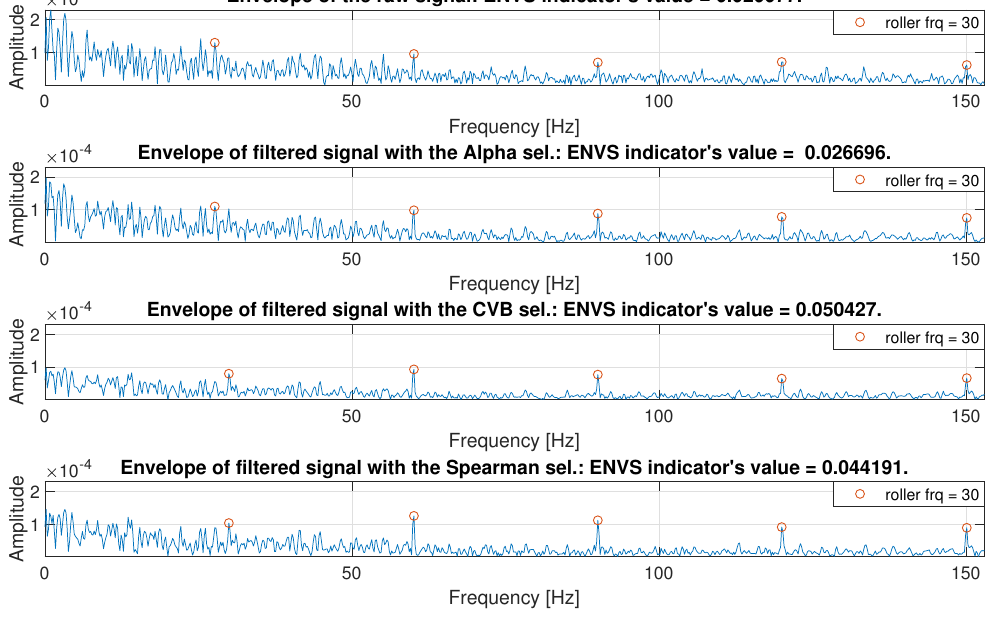
Figure 48. Envelope